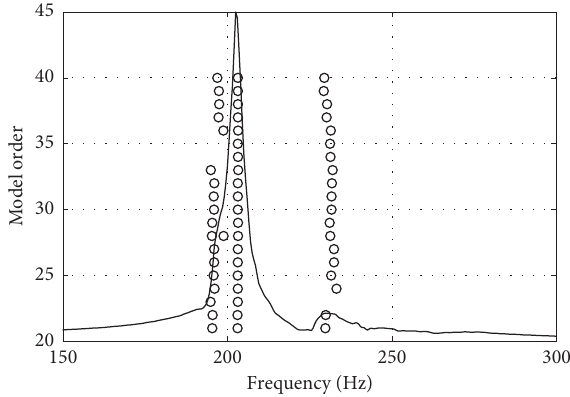
Figure 23: Variation of the identified frequencies (below 400Hz) with model order when using 􏽥 h ( k ) by IFFT of S ( ω ) , for damage case ① .